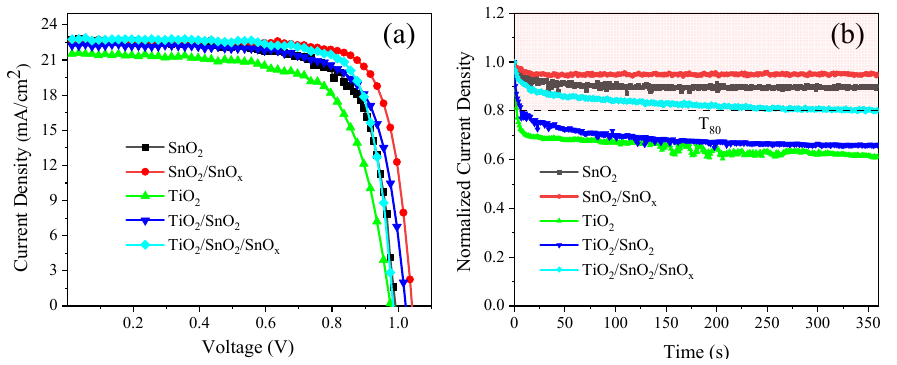
Figure 2. ( a ) Photovoltaic performance and ( b ) stability of current density of the perovskite solar cells with the different film multi-layers of ETL. Table 1. Photovoltaic parameters of PSCs fabricated with the different conditions of ETL.